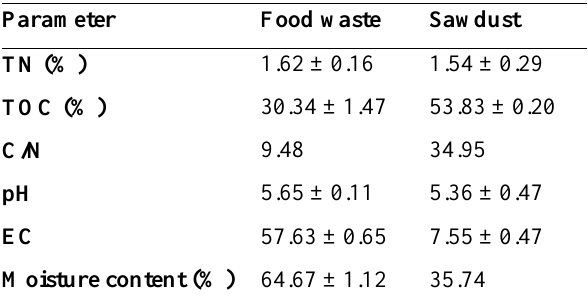
Table 1 Basic characteristics of materials used in